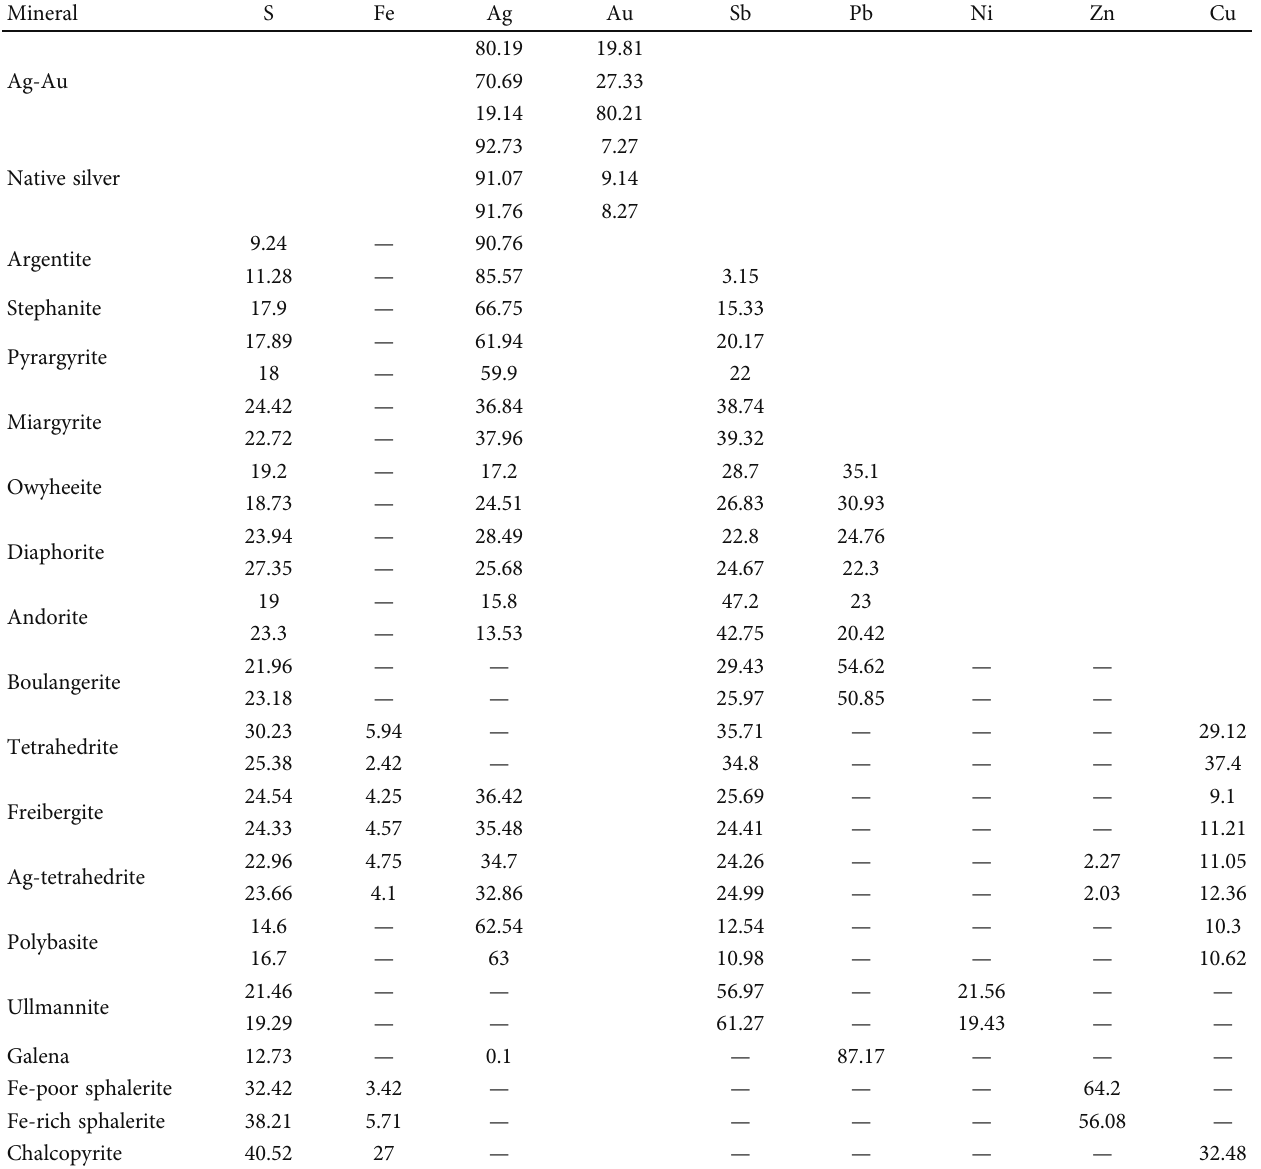
Table 1: Representative composition of SEM analysis (wt%) of silver and base metal minerals of the Roc Blanc deposit. Mineral S Fe Ag Au Ag-Au